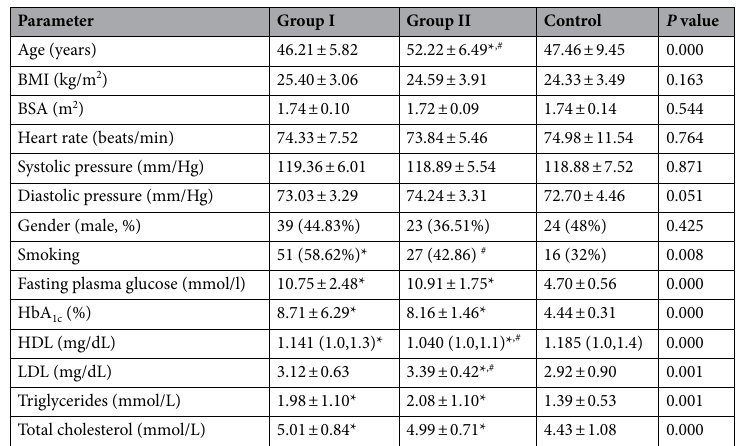
Table 1. Clinical and laboratory parameters. BMI, body mass index; BSA, body surface area; HbA 1c , glycated hemoglobin; HDL, high-density lipoprotein; LDL, low-density lipoprotein. Data are presented as mean ± standard deviation, median (interquartile range), or number (%). * Compared with control group, P < 0.05. # Compared with group I, P < 0.05.